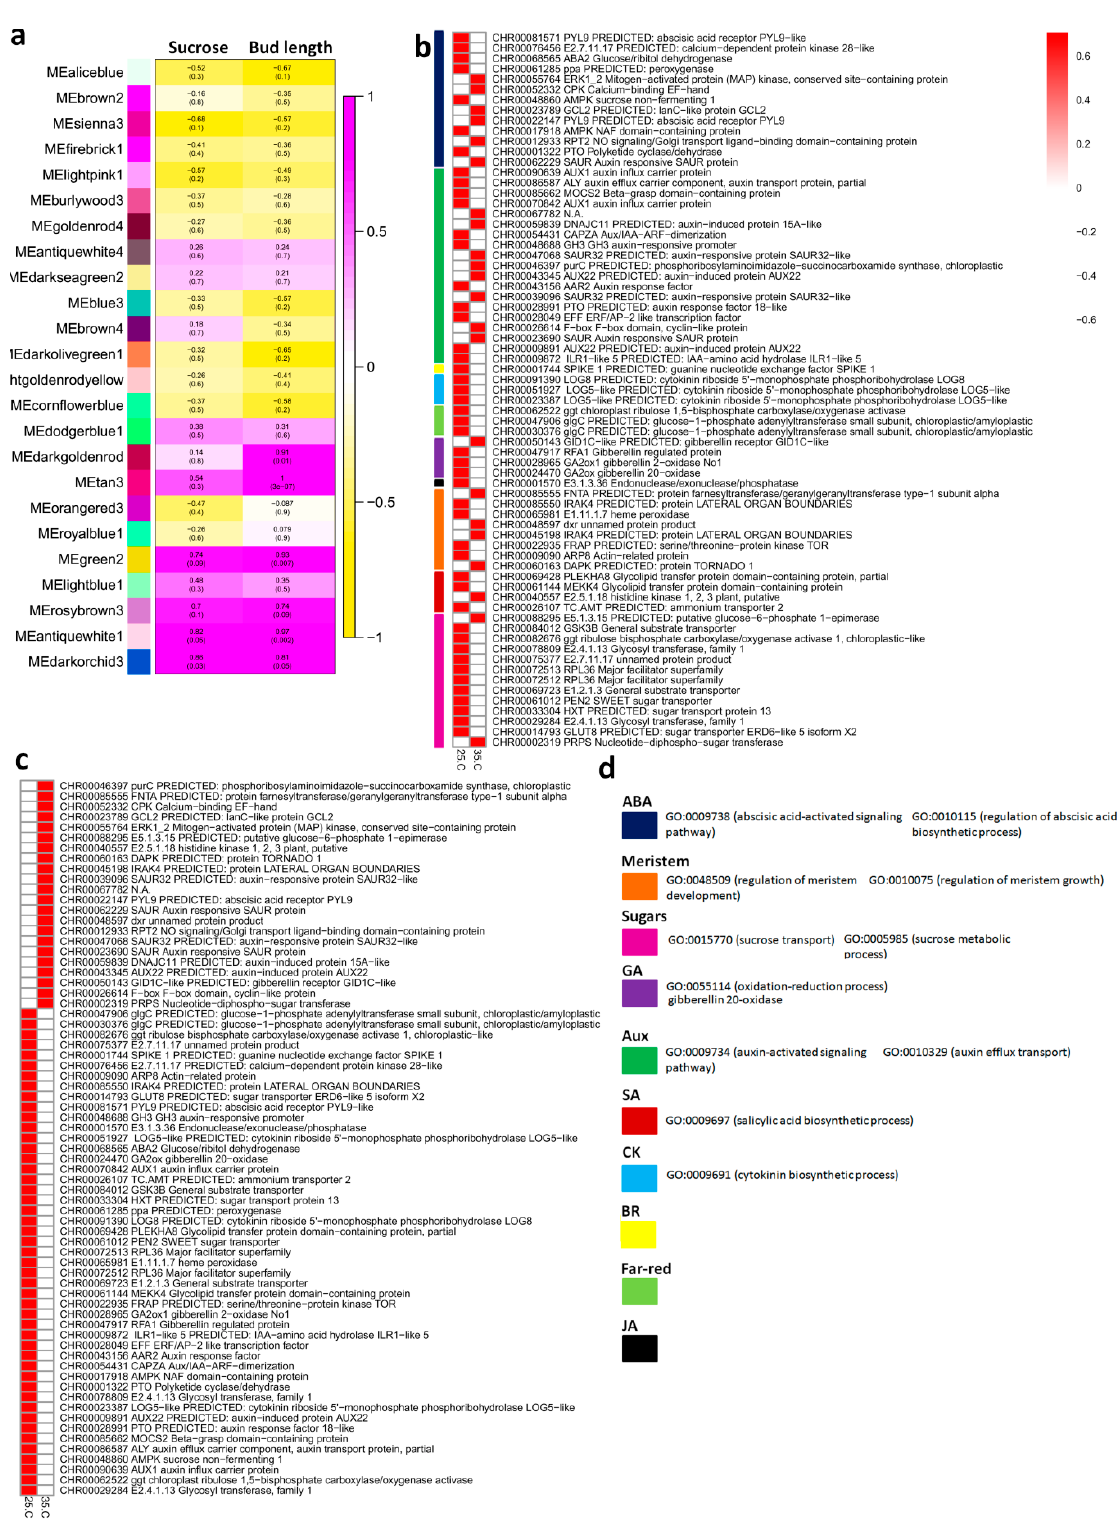
Figure 3. WGCNA analysis of DEGs. ( a ) Module enrichment for sucrose homeostasis and bud dynamics. MEdarkorchid3 is the most enriched module for sucrose signalling and bud outgrowth; ( b ) Enrichment of important terms in the module MEdarkorchid3; ( c ) Clustering of terms enriched in MEdarkorchid3 for important regulators of bud dynamics as shown in part ‘b’; ( d ) Biological process annotations of some important bud regulators.